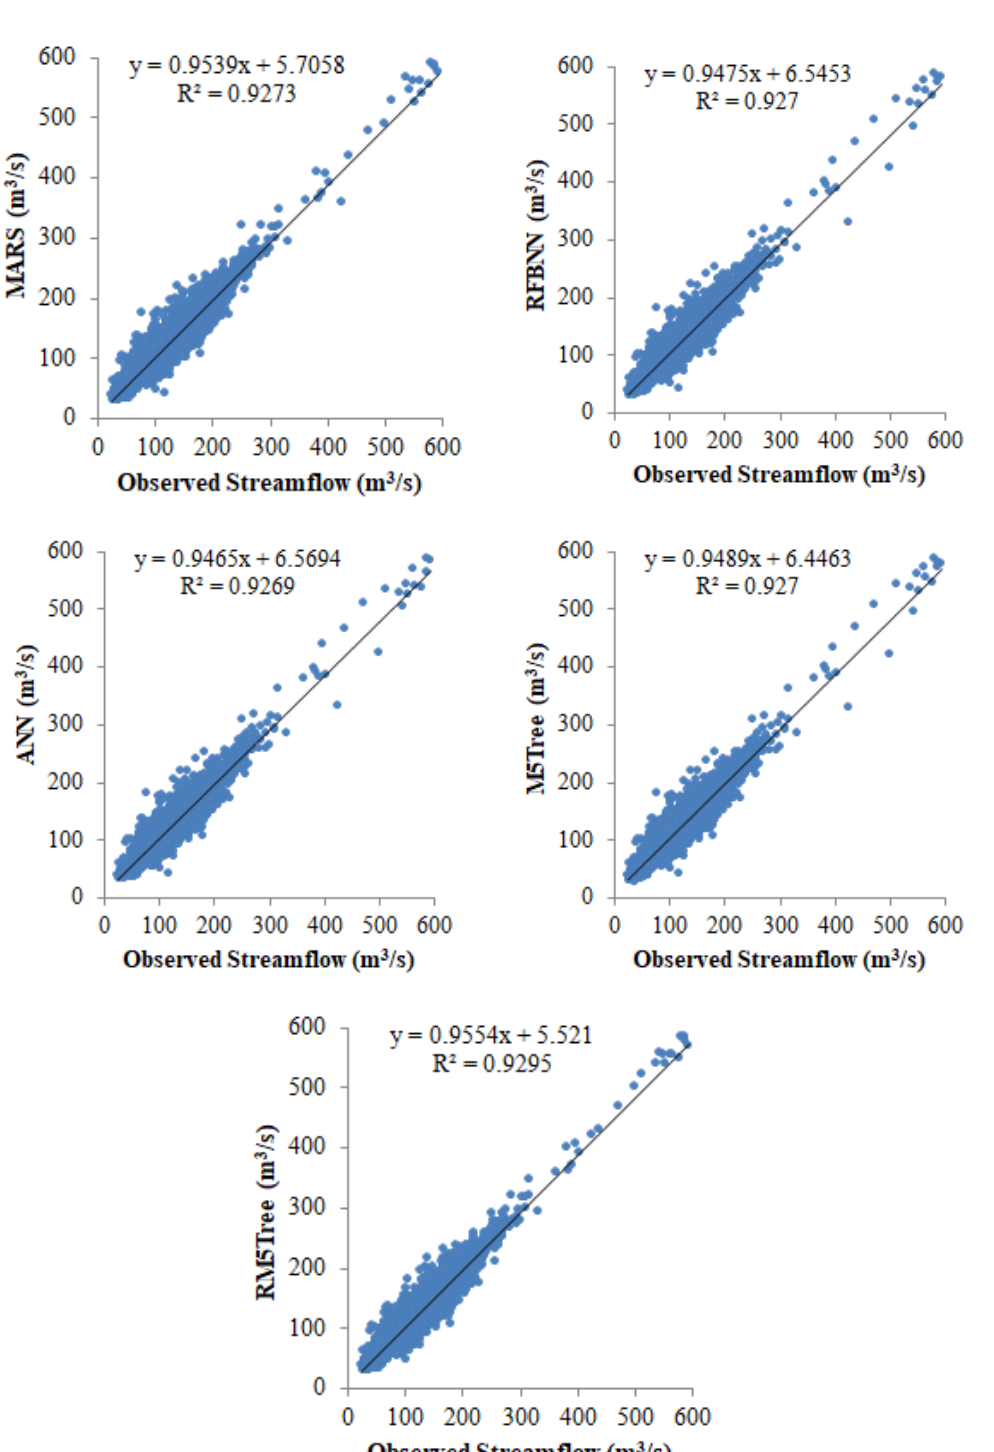
Figure 8. Scatterplots of the observed and predicted streamflow by RM5Tree, M5Tree, RBFNN, ANN, and MARS models in the test period of Skallbole Station (downstream).